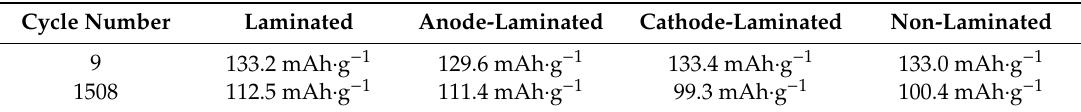
Table 1. Capacity fade of laminated / partially laminated / non-laminated cells in the fast-charging cycle test.